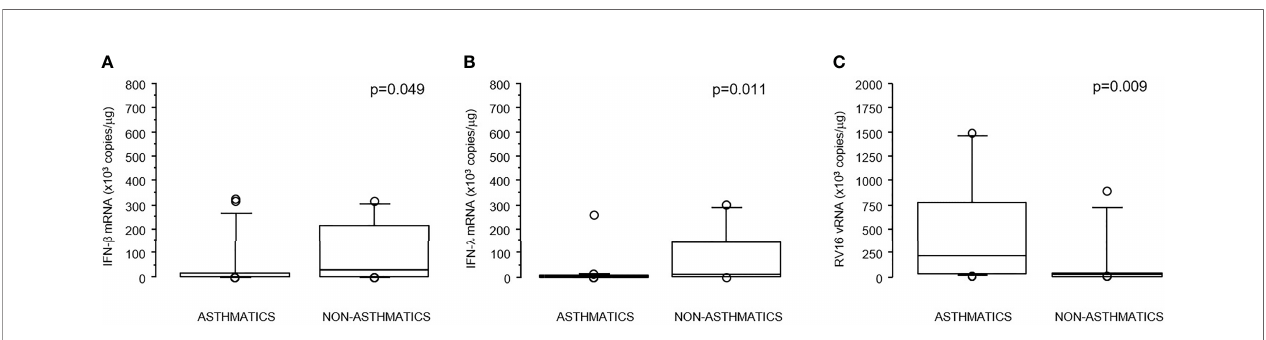
FIGURE 1 | (A – C) Boxplots reporting values of IFN- l mRNA (A) , IFN- b mRNA (B) , and RV16 vRNA (C) in asthmatics and non-asthmatics children. Bottom and top of the box-plot: 25 th and 75 th percentiles; solid line: median; brackets: 10° and 90° percentiles.